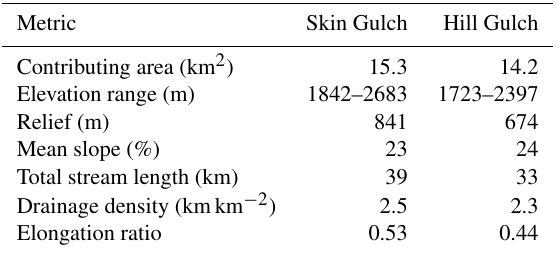
Table 1. General watershed metrics for Skin Gulch and Hill Gulch. Metric Skin